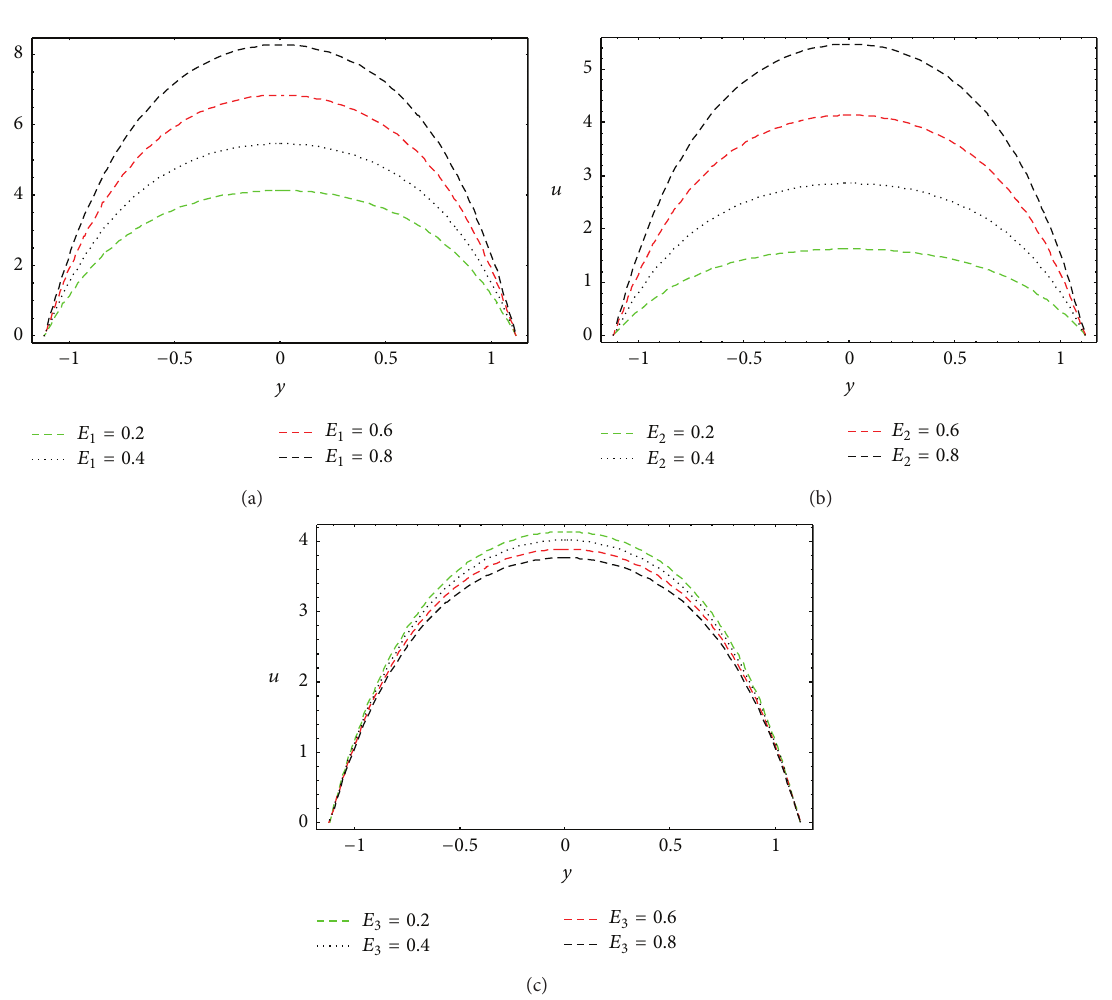
Figure 3: Variation on 𝑢 when 𝑅 = 0.01 , 𝛿 = 0.01 , 𝜀 = 0.2 , 𝛽 = 0.01 , 𝑡 = 0.2 , 𝑀 = 2.6 , 𝜆 1 = 0.1 , 𝜆 2 = 0.0 , and 𝑥 = 0.3 plotted for (a) for different values of 𝐸 1 , (b) for different values of 𝐸 2 , and (c) for different values of 𝐸 3